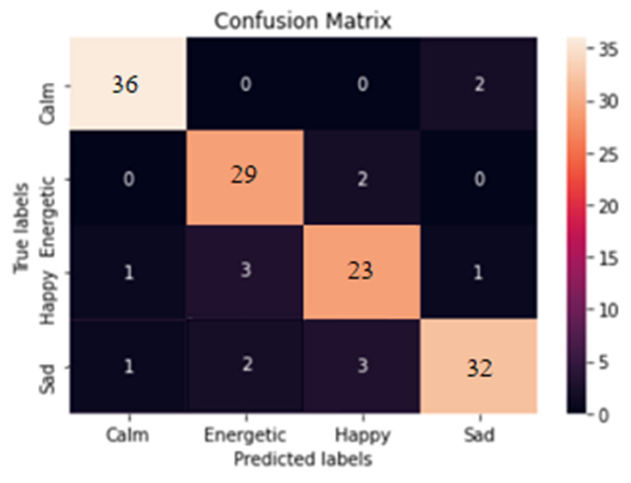
Figure 6. Confusion Matrix.